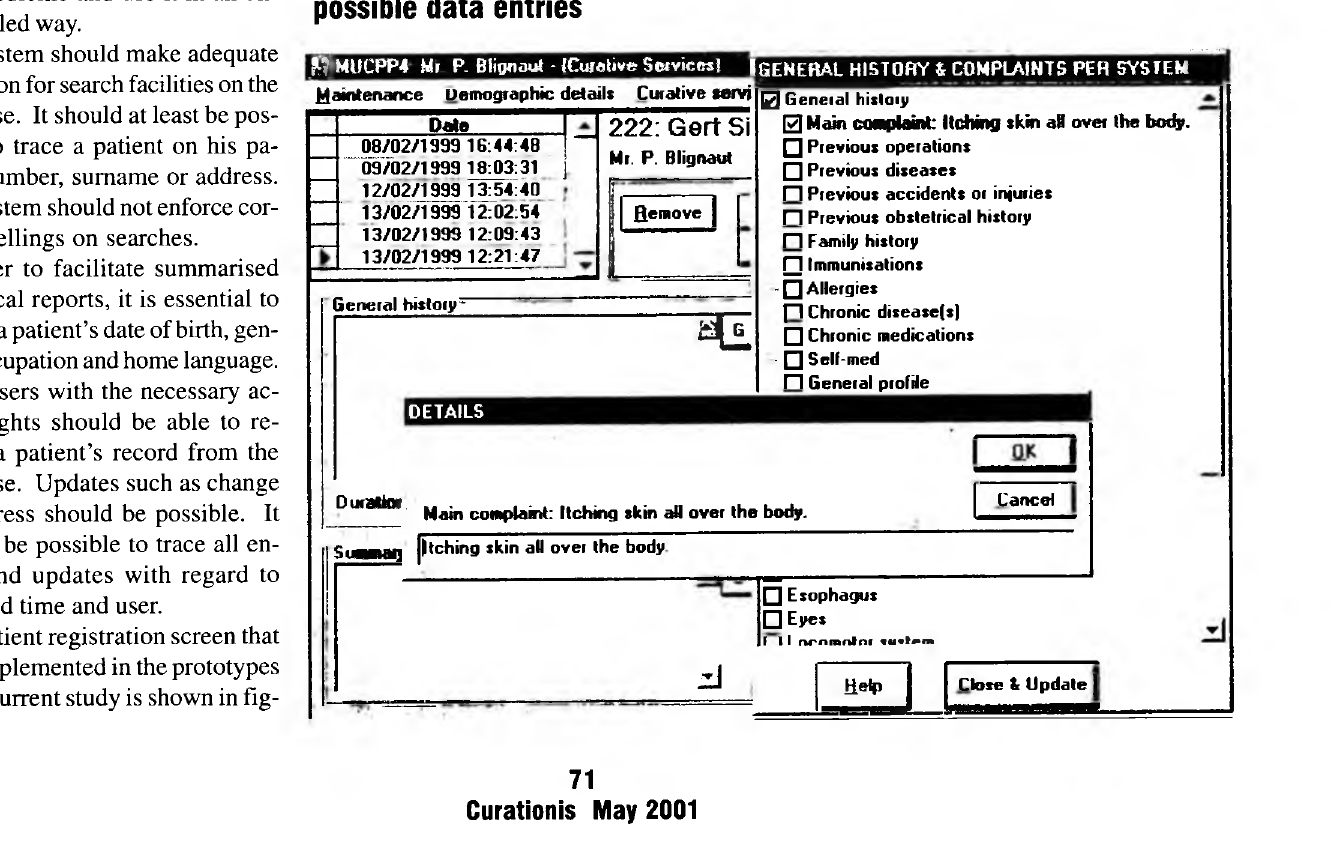
Figure 5 : Input screen for curative details, showing the list of possible data